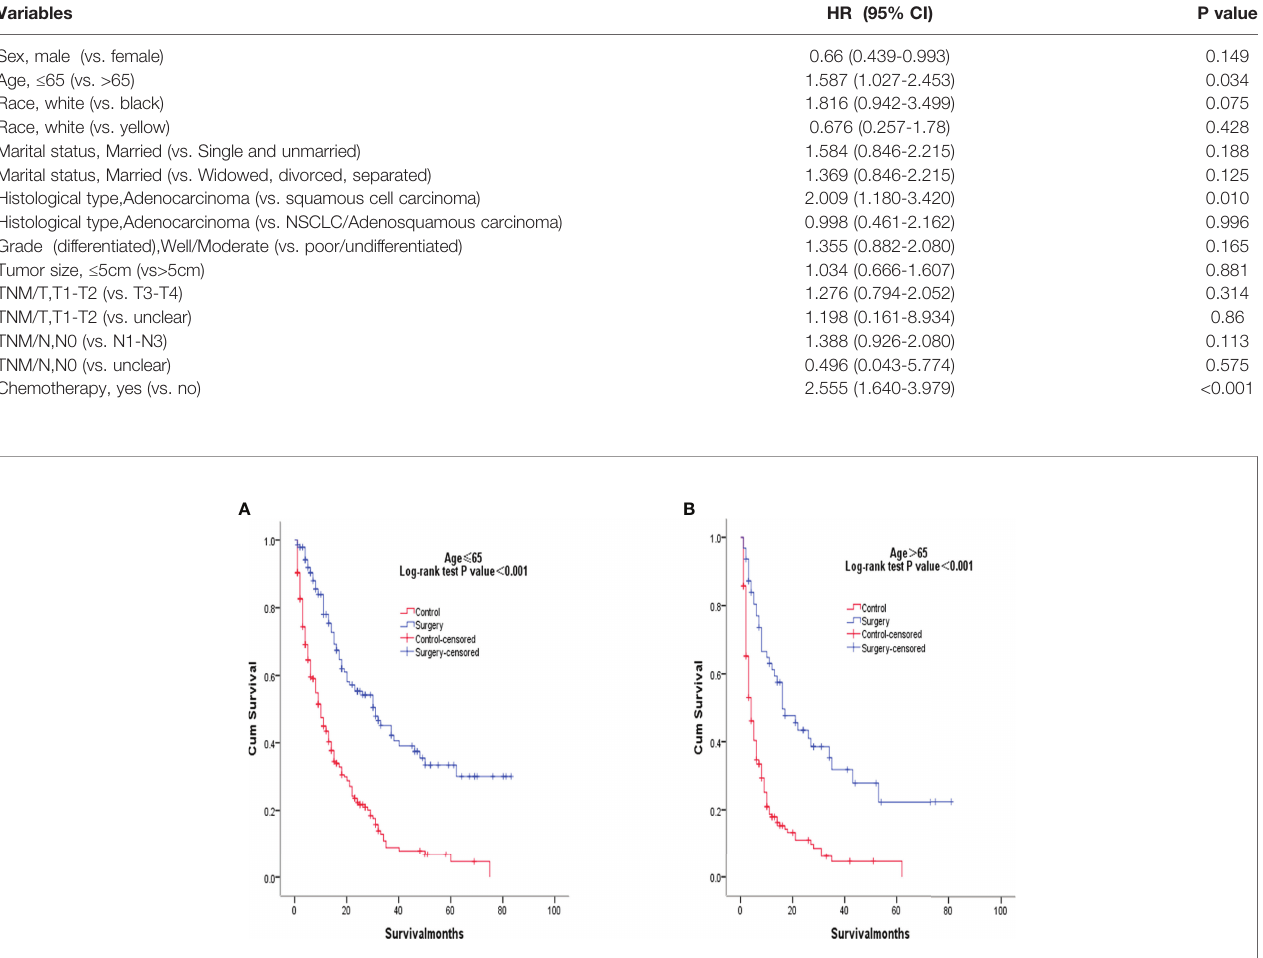
FIGURE 3 | Kaplan-Meier overall survival curves of surgery-treated patients vs control after propensity score matching strati fi ed by age ≤ 65years (A) , age> 65 years (B)